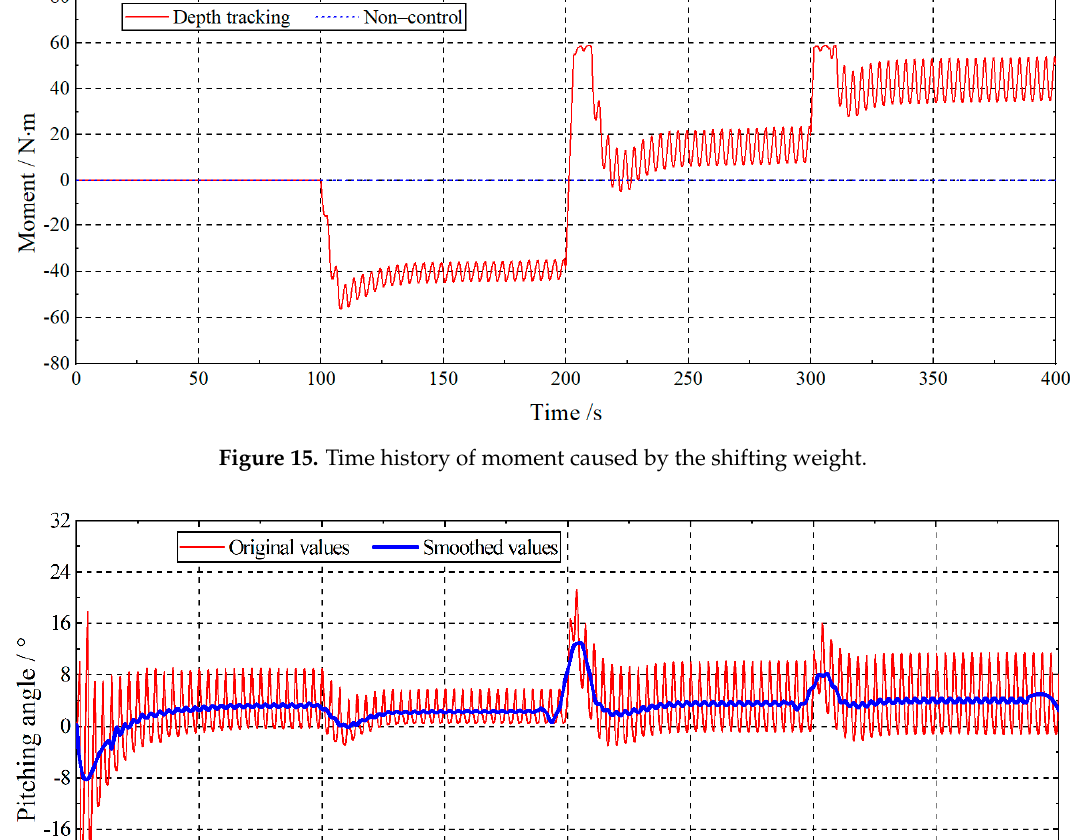
Figure 14. Time history of longitudinal position of shifting weight.